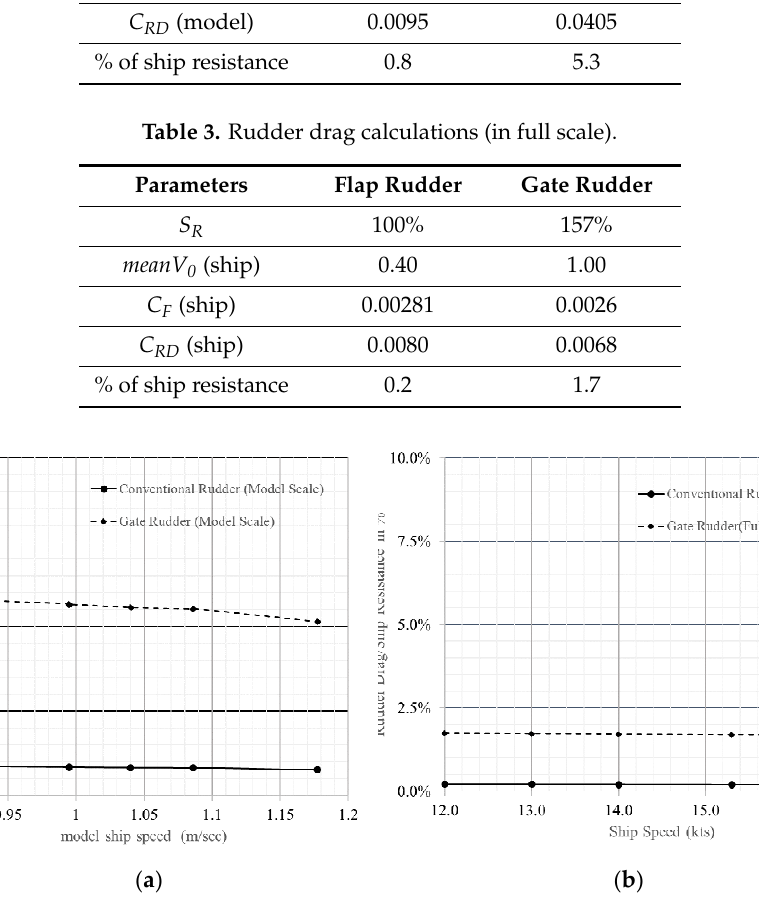
Figure 5. Rudder drag in % of ship resistance for model ( a ) and full scale ( b ).